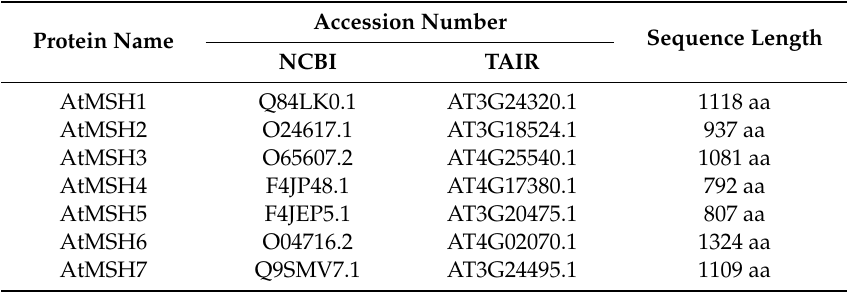
Table 6. AtMSH proteins accession numbersfrom the National Center for Biotechnology Information (NCBI) and the Arabidopsis Information Resource